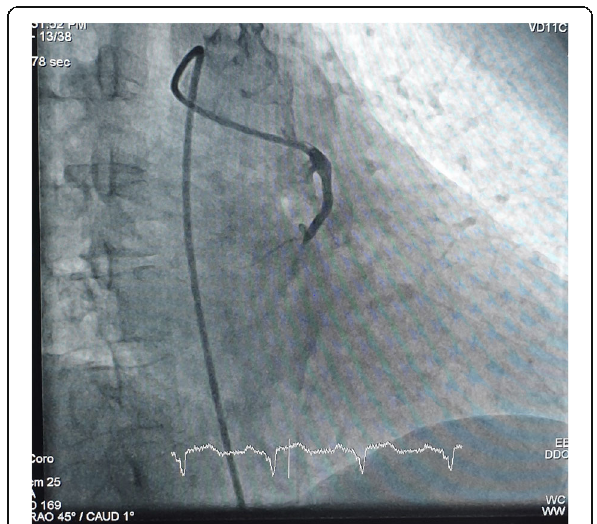
Fig. 2 RAO showing anomalous origin and proximally cutoff RCA